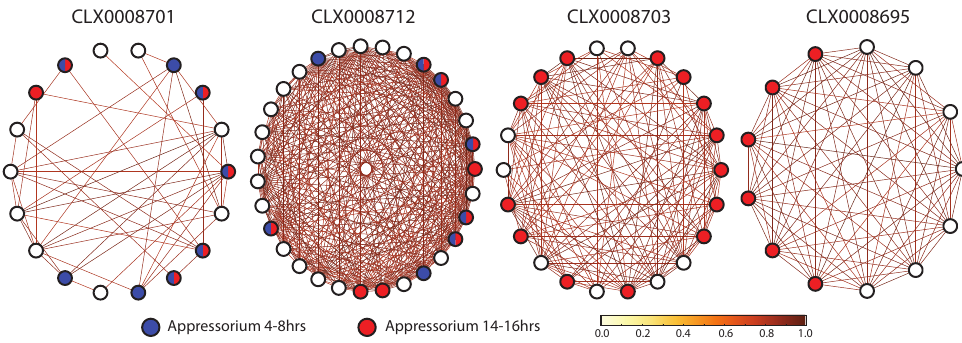
Figure 4. Examples of entities enriched for up-regulated M. oryzae genes during appressorium development. CLX0008701 and CLX0008712 are enriched for genes during both 4–8 h and 14–16 h of appressorium development. Entities CLX0008712 and CLX0008695 are enriched for genes up-regulated during 14–16 h of appressorium development. Nodes represent genes and edges between nodes represent correlated expression of genes across 46 RNA-Seq samples. Edges are coloured by Pearson’s Correlation Coefficient ( R 2 ) and only shown if R 2 > 0.9. Genes up-regulated during 4–8 h and 14–16 h of appressorium development are coloured blue and red